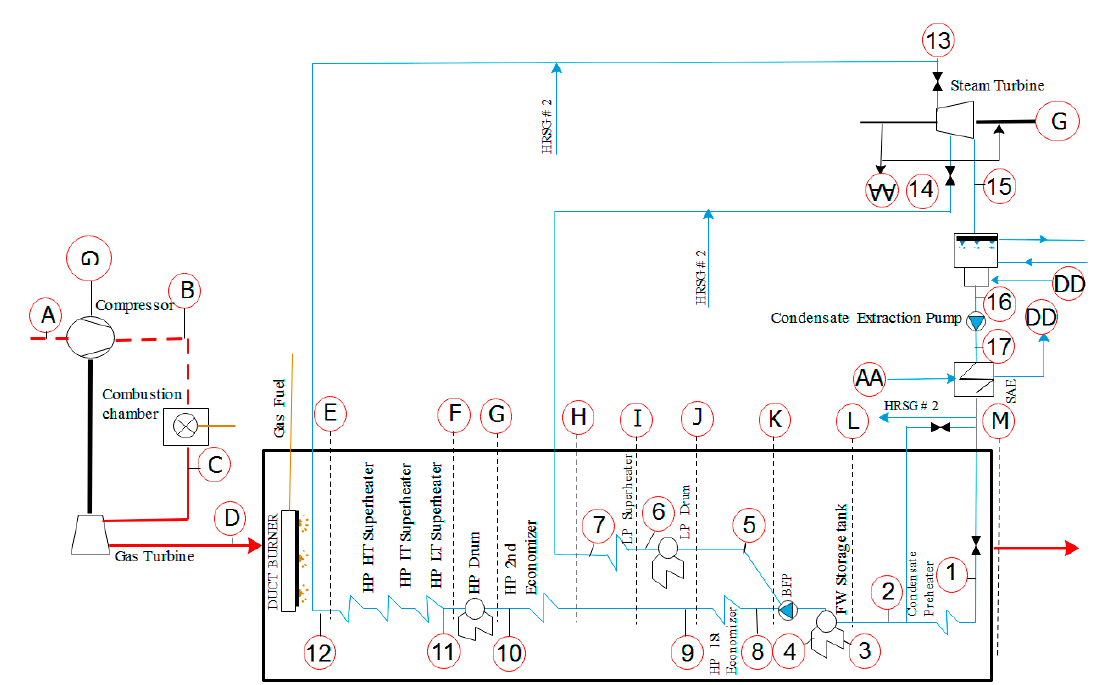
Figure 1. Schematic diagram of Shahid Salimi Neka power plant. HRSG, heat recovery steam generator as proposed by Ameri et al. [14]. Reprinted figure with permission from Ameri, M., Ahmadi, P., Khanmohammadi, S. Exergy analysis of a 420 MW combined cycle power plant. 2008 , 32 , 175–183.